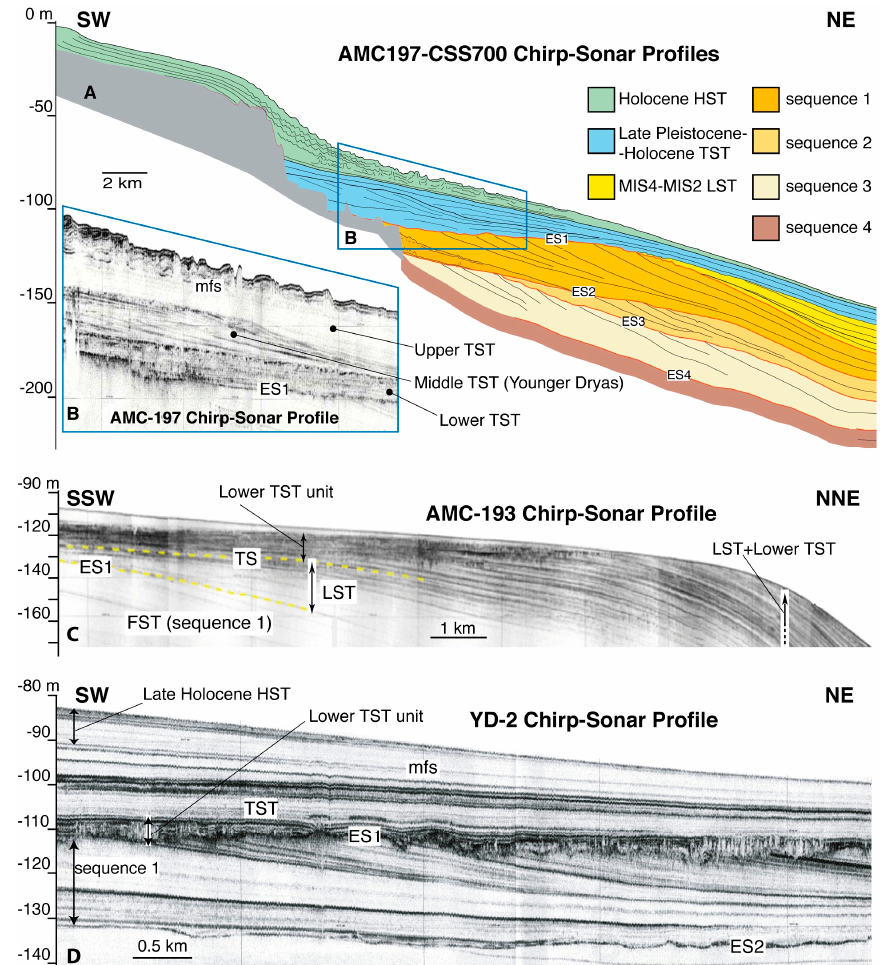
Figure 3. Stratigraphic architecture and lateral variability of Upper Pleistocene-Holocene units in the Central Adriatic (location of profiles in Figure 1). Four sequences separated by erosional unconformities (ES1–ES4) record as many 100-ky glacio-eustatic cycles (( A ) modified from [58]). Above unconformity ES1, capping the youngest sequence 1, post-glacial TST and highstand (HST) deposits are present (( B – D ); mfs = maximum flooding surface). The TST shows a vertical tripartition ( B ), with a lower TST unit characterized by high lateral variability from north ( C ) to south (( D ) modified from [43]), moving away from the main Po River sediment source.